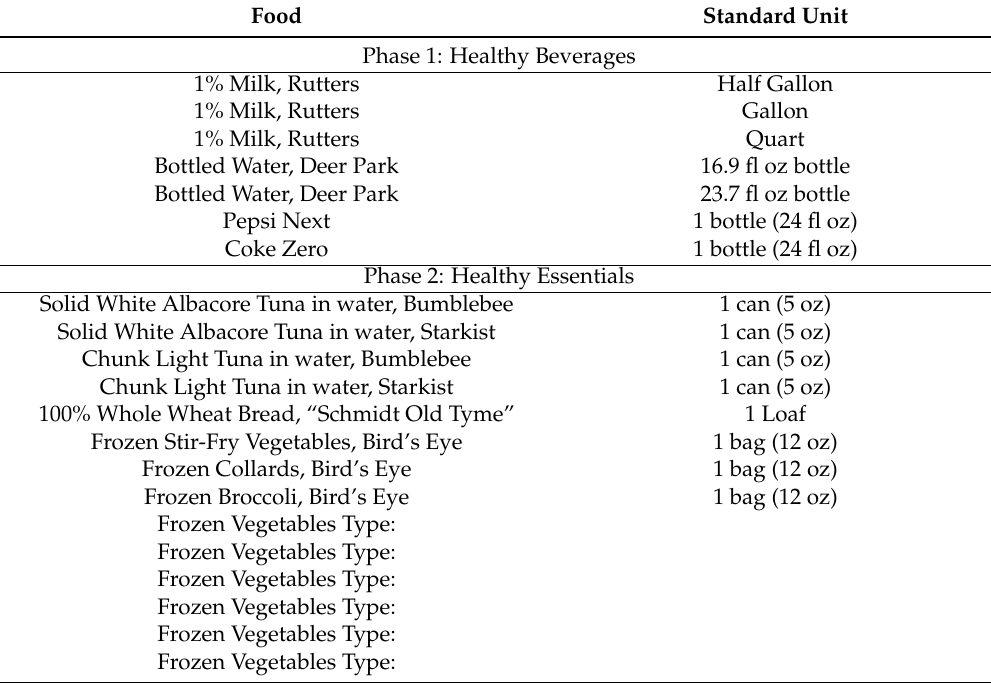
Table A1. List of BHRR promoted foods (from BHRR’s Store Impact